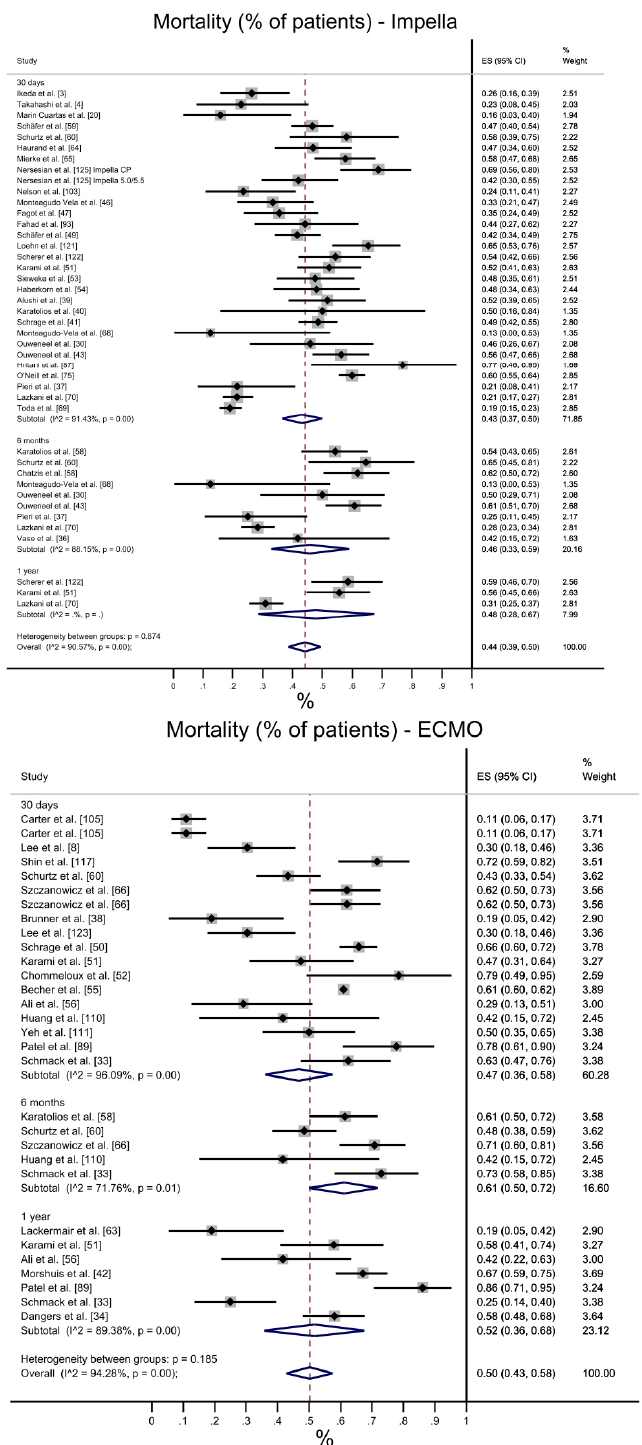
Figure 2. Mortality: Impella vs. VA-ECMO [3,4,8,20,30,33,34,36-43,46,47,49–56,58–60,63–66,68– 70,75,87,89,93,103,105,110,111,117,121–123,125].